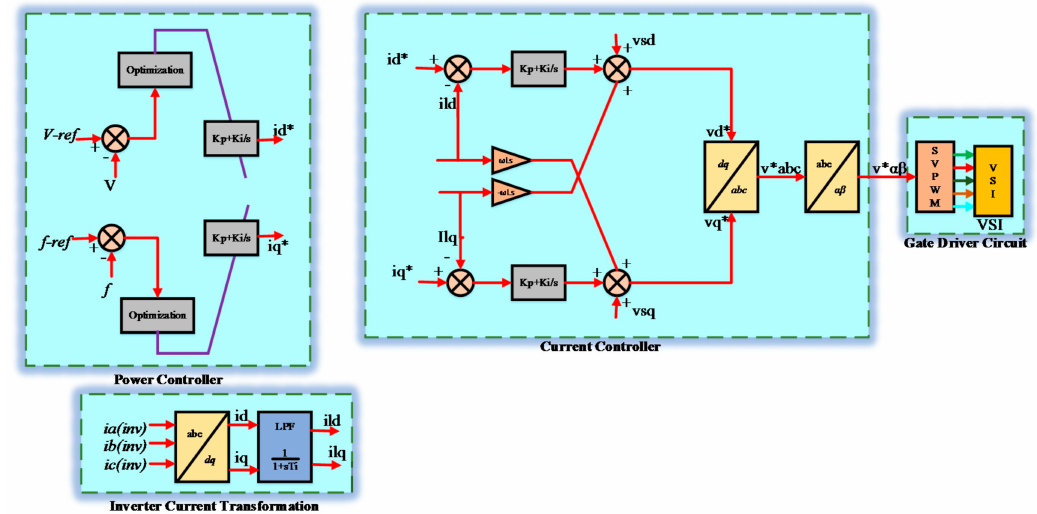
Figure 3. Internal structure of the proposed